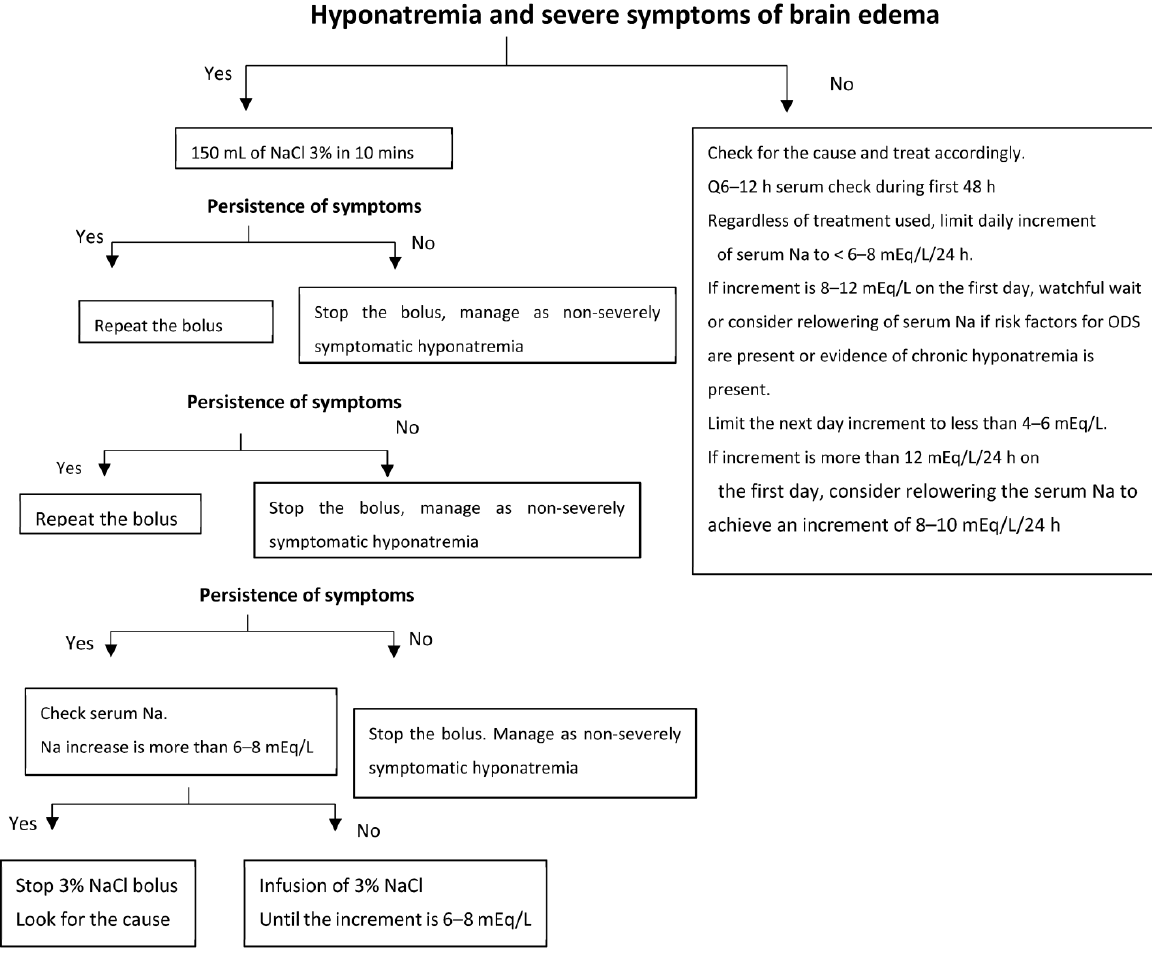
Figure 1. Proposed algorithm for management of hyponatremia with regards to brain complications.